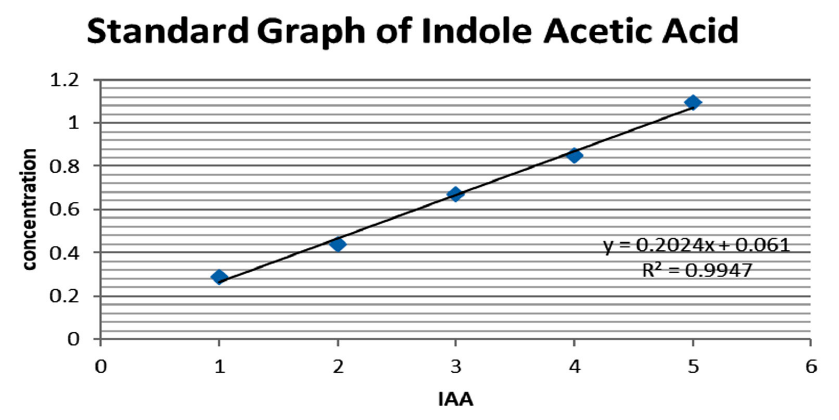
Fig. 1. Standard graph of